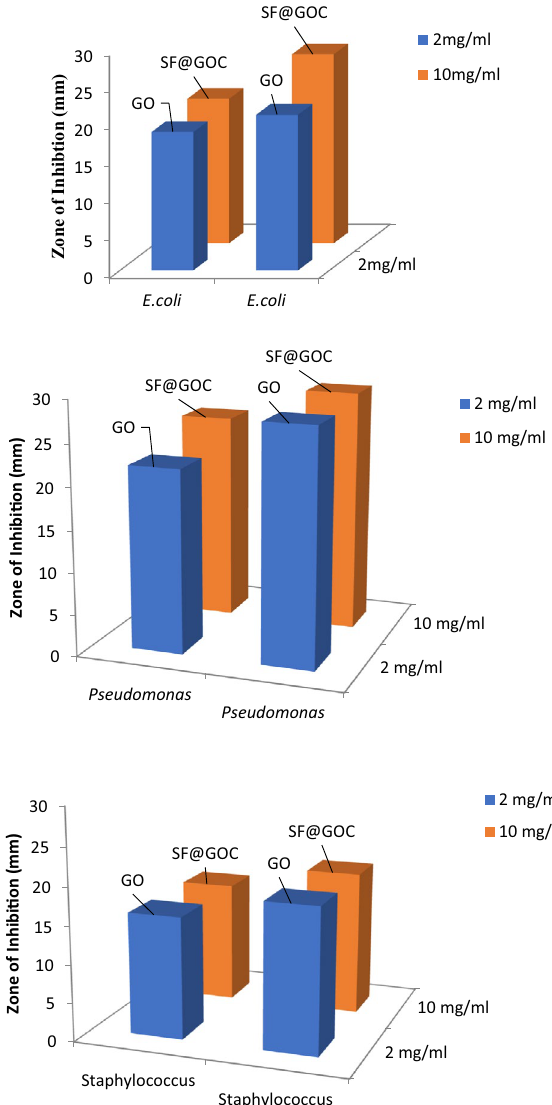
Figure 8. Zone of inhibition against Escherichia coli, Pseudomonas aeruginosa, and Staphylococcus aureus